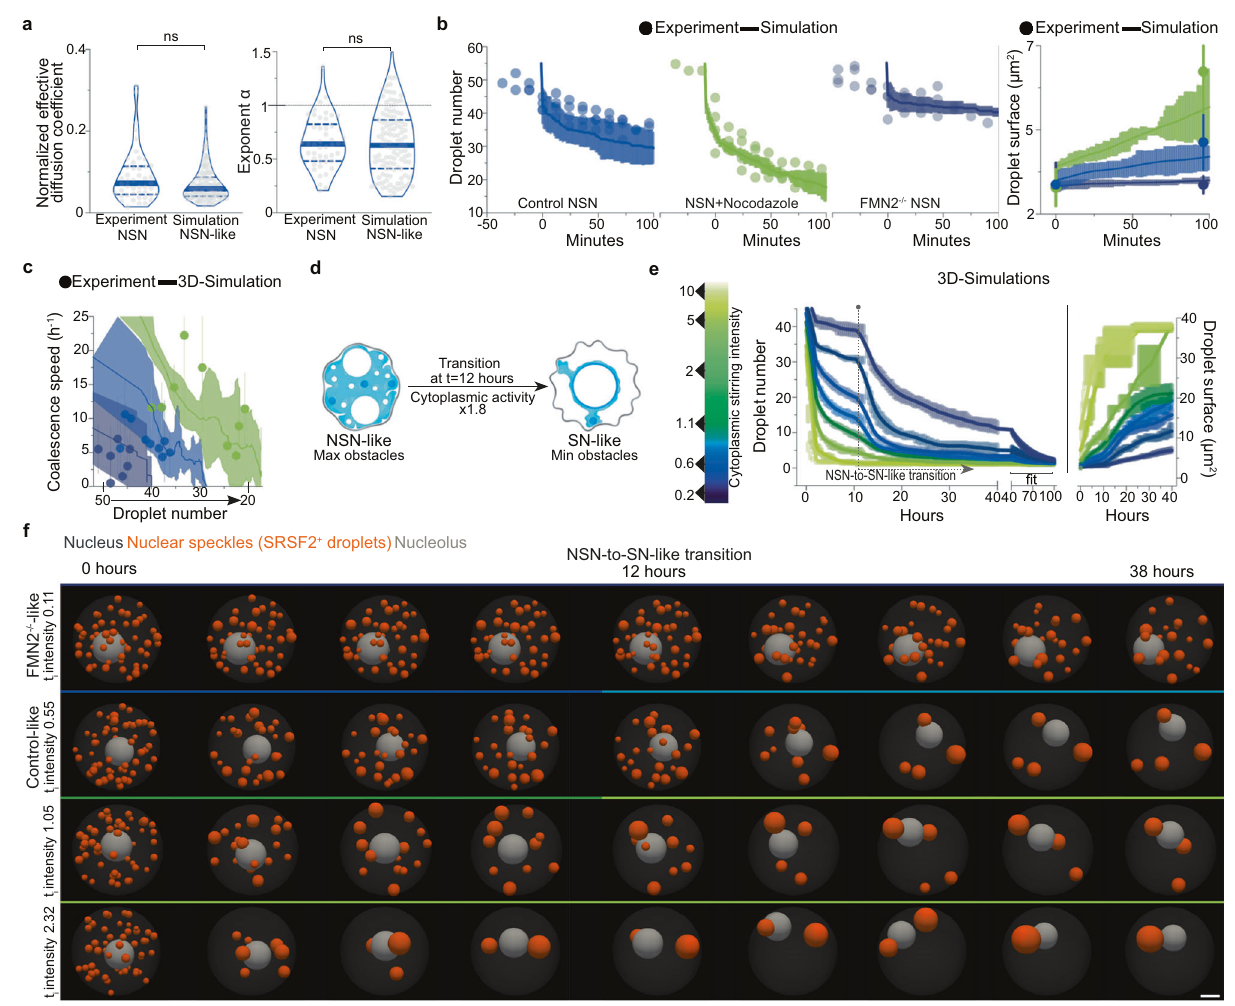
Fig. 3 | Computational models predict cytoplasmic forces to be predominant drivers of nuclear condensate remodeling. a Effective diffusion coef fi cients normalized by droplet size and droplet diffusive exponents α from SRSF2-GFP experiments (NSN oocytes) and simulations with NSN-like obstacles; droplet number, Experiment=46; Simulation=115; violin plots with median±quartiles; P valuesderivedfromtwo-tailedMann – Whitney U -tests,nsnotsigni fi cant, P =0.1203 and P =0.8741. b Droplet number (left) and size (right) evolution in NSN-like simulations (lines) and in NSN-oocyte experiments (circles) for Control, Nocoda- zole, and FMN2 − / − conditions; simulations and experiments were aligned on com- parable time frames by de fi ning 45 droplets as t =0; simulations performed fi ve times per condition and experimental data from four NSN oocytes per condition. c Nucleardroplet coalescencespeedper hour relative to dropletnumberdecrease inexperimentalNSNconditions(Controlinblue,Nocodazoleingreen,andFMN2 − / − in dark blue) and computational models with simulated NSN Control-like, Noco- dazole-like, and FMN2 − / − -like cytoplasmic activity; error represents mean±95% con fi dence interval; the number of experimental measurements, Control NSN=9, Nocodazole=9, FMN2 − / − =7; 5 simulations per condition. d Schematic